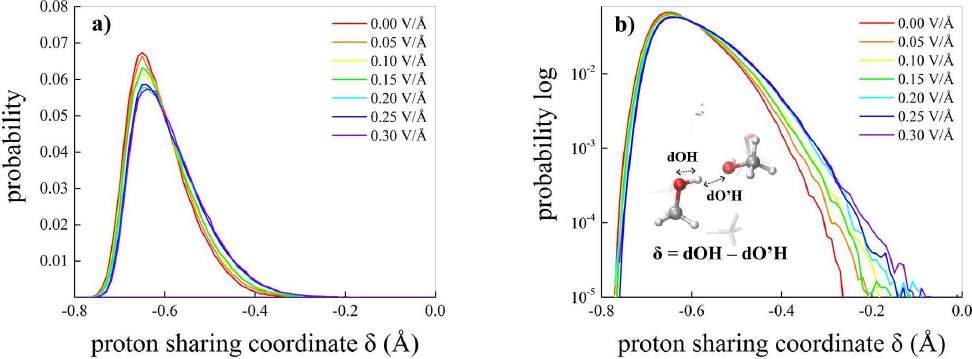
Figure 5. Probability distributions of the proton-sharing coordinate δ between methanol molecules under linear ( a ) and logarithmic ( b ) plots at different electric field strengths as detailed in the legends. In the inset of ( b ), the definition of the coordinate, which is determined for every hydrogen atom in the system involved in a tight H-bond, is